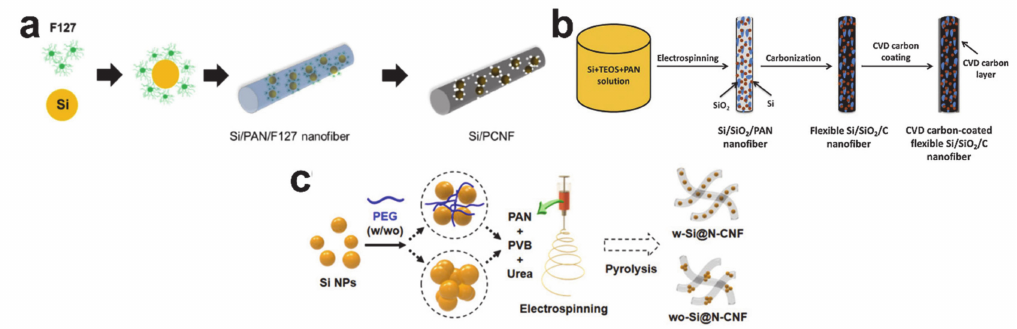
Figure 20. Functional additive introduced silicon / carbon composite nanofibers. ( a ) Pluronic F127 containing precursor driven silicon / porous carbon composite nanofiber (reprinted with permission from [230]; copyright 2015 Elsevier), ( b ) carbon-coated silicon / silica / carbon composite nanofiber (reprinted with permission from [231]; copyright 2015 Elsevier), and ( c ) polyethylene glycol (PEG) containing precursor driven carbon nanofiber containing uniformly dispersed silicon nanoparticles (reprinted with permission from [232]; copyright 2017